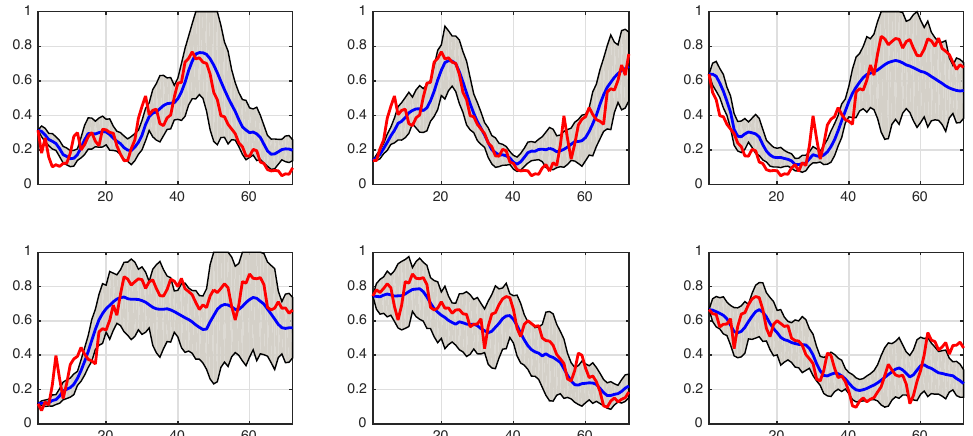
Figure 13. Hybrid bands for six random days in the test-set [blue is the centroid, the red one is the actual power].